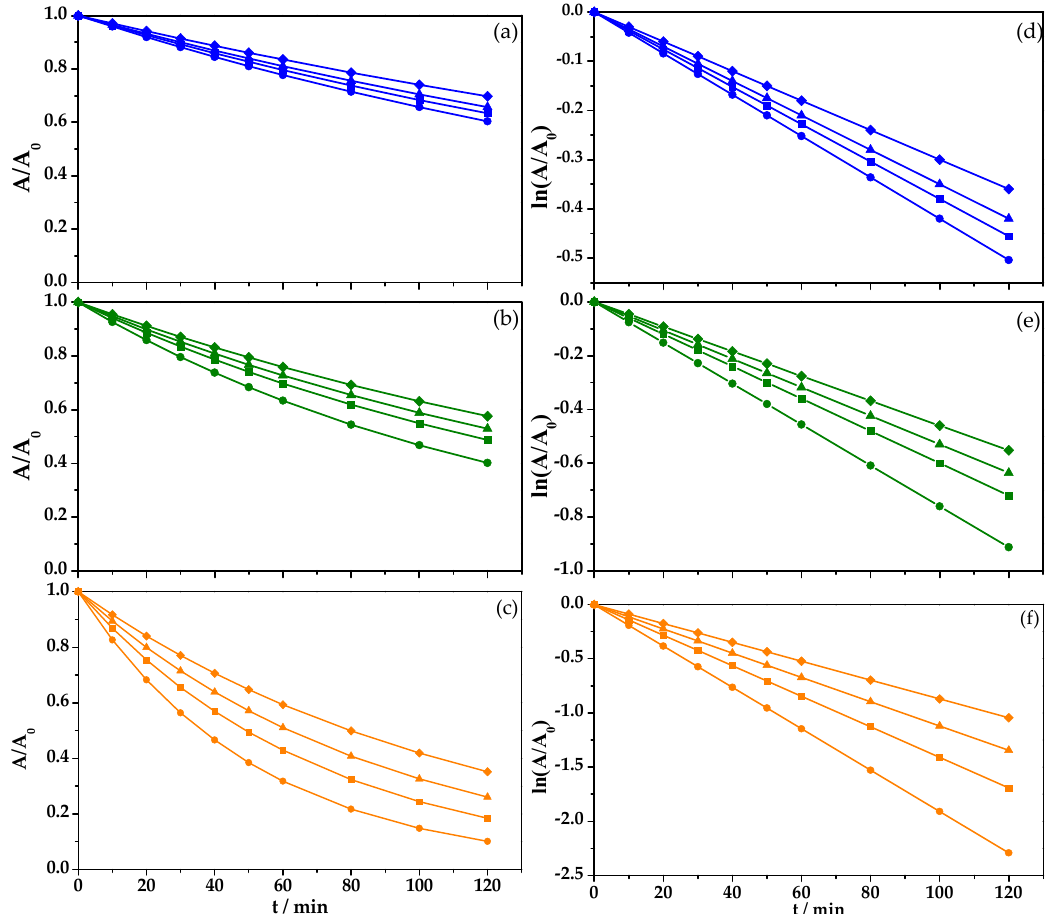
Figure 6. Removal of an aqueous solution of BBR azo dye, C 0 = 50 mg/L, during the oxidation process in 0.1 M of HClO 4 with a solution volume of 0.1 L, ( a ) j = 7 mA cm − 2 , ( b ) j = 15 mA cm − 2 , ( c ) j = 30 mA cm − 2 , and fit to first order reaction kinetics ( d ), ( e ) y ( f ), respectively; ( (cid:7) ) BDD without FeSO 4 , ( (cid:78) ) 1 mM of FeSO 4 , ( (cid:4) ) 6 mM of FeSO 4 , and ( • ) 12 mM of FeSO 4